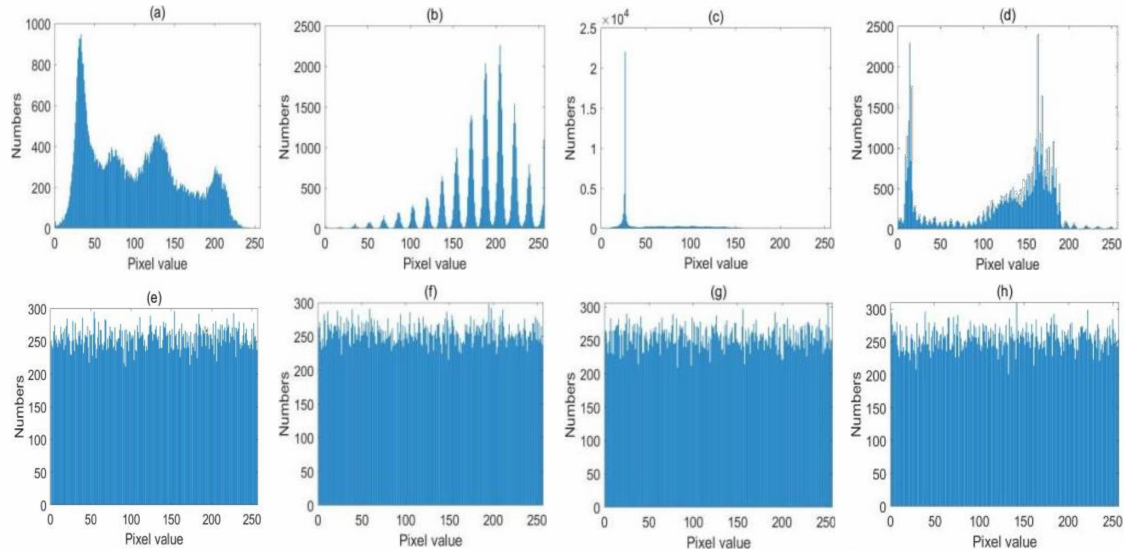
Figure 14. The histogram analysis: ( a – d ) Original images: Baboon, Horse, Flower, Cameraman; ( e – h ) Encrypted images: Baboon, Horse, Flower, Cameraman.